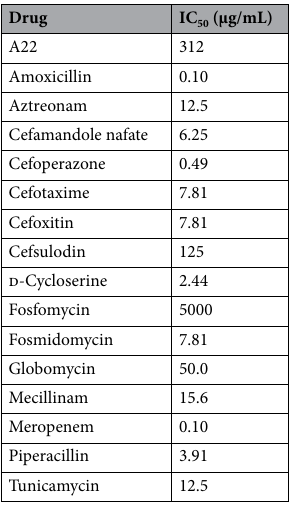
Table 1. IC 50 values of 16 antibiotics, including various β-lactams. IC 50 values (µg mL −1 ) for S. linguale ATCC33905 strain are the means from three independent